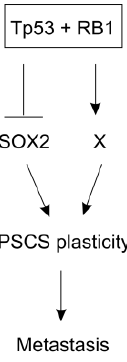
Figure 3. Current evidence reveals a critical role of TP53 together with RB1 in the suppression of SOX2 expression and affecting other events (X). SOX2 and X confer the cell plasticity of PCSCs, which promotes PC metastasis and induces neuroendocrine PC (NEPC) in response to anti-androgen therapies.